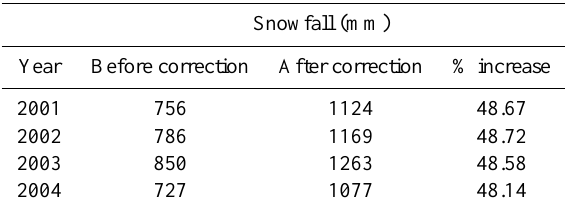
Table 6. Total snowfall during October–June of 2001–2004 (before and after snowfall correction and percentage increase with respect to uncorrected